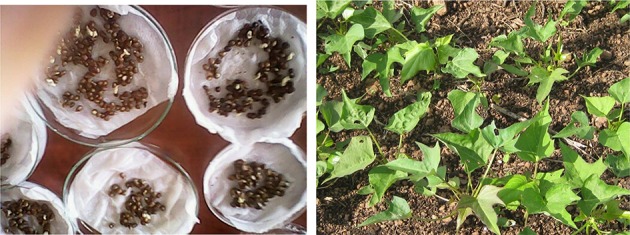
Germination of sweetpotato seeds after scarification (left) and seedling plants (right).